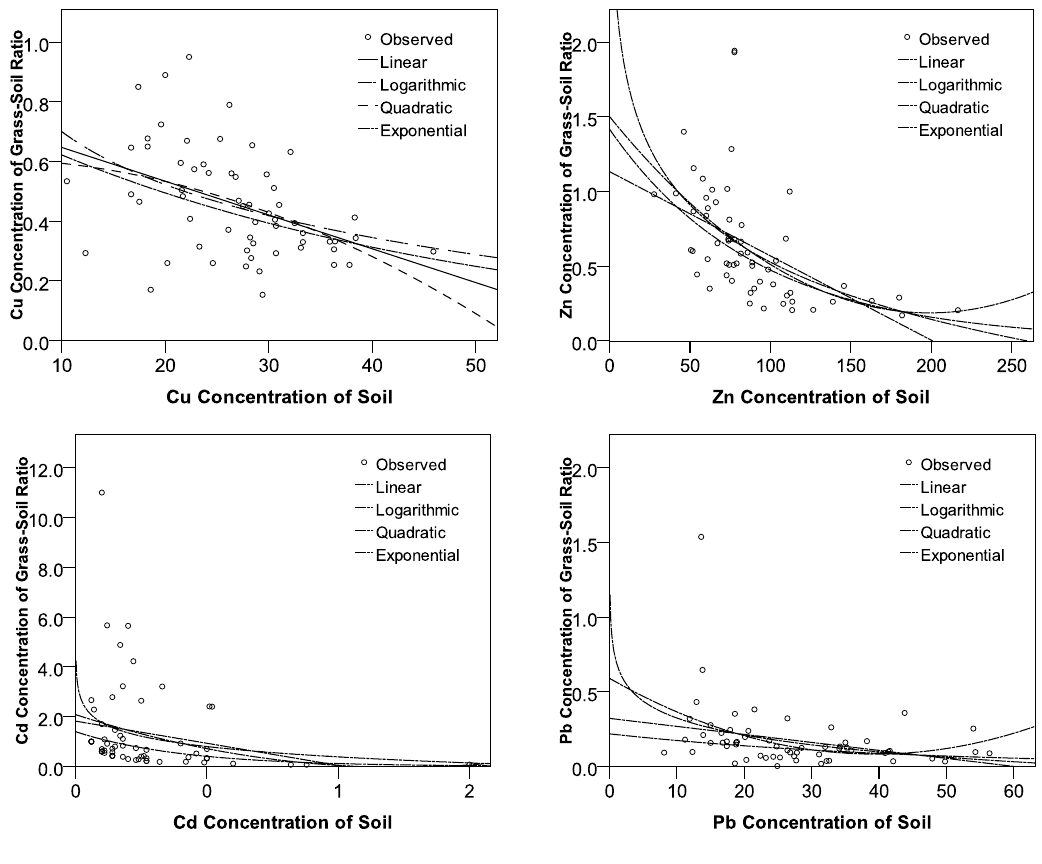
Figure 6. Relationship between the ratio of heavy-metal concentration in grass to soil and heavy-metal concentrations in soil.